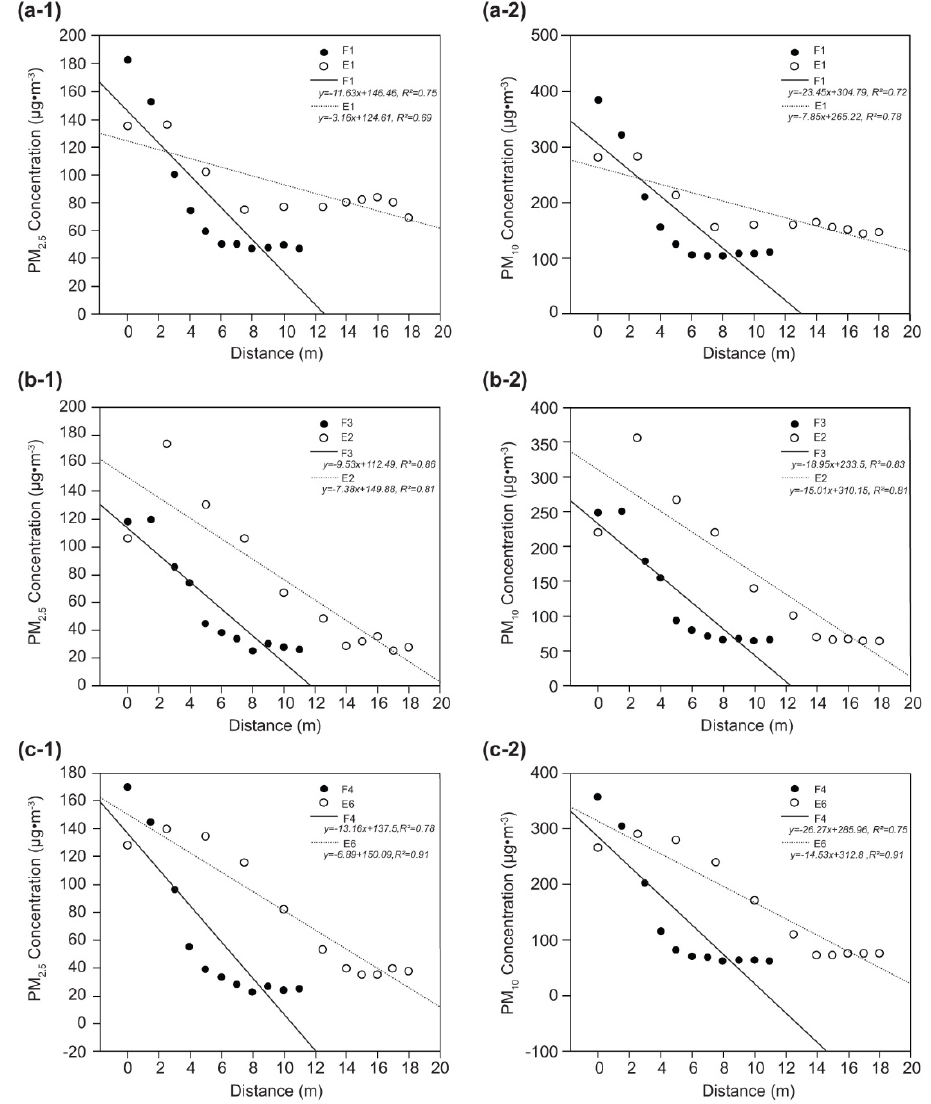
Figure 8. Changes in the PM density (dots) and linear regression predictions (lines) of the PM concentrations at the pedestrian breathing height (1.5 m) according to the distance from the source center of the roadway for three different vegetation models: ( a-1 , b-1 , c-1 ): PM 2.5 ; ( a-2 , b-2 , c-2 ): PM 10 . ( a ) single-layer vegetation, ( b ) multi-layer vegetation, and ( c ) vegetation barrier.